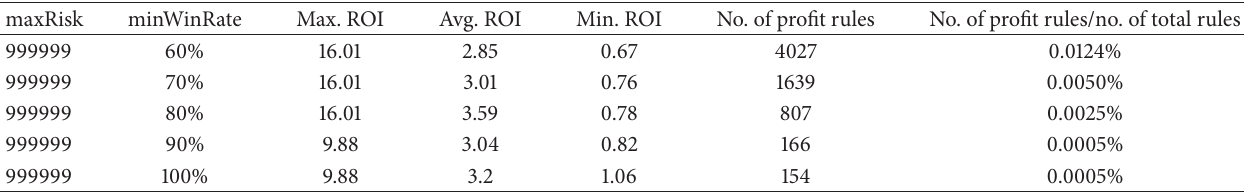
Table 7: Mining results of using various minWinRates.